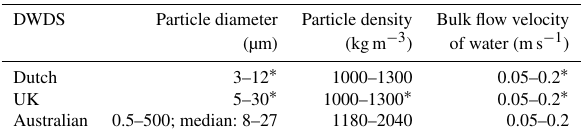
Table 2. Overview of common particle diameter and density and bulk flow velocity conditions in DWDS for the Netherlands, the UK, and